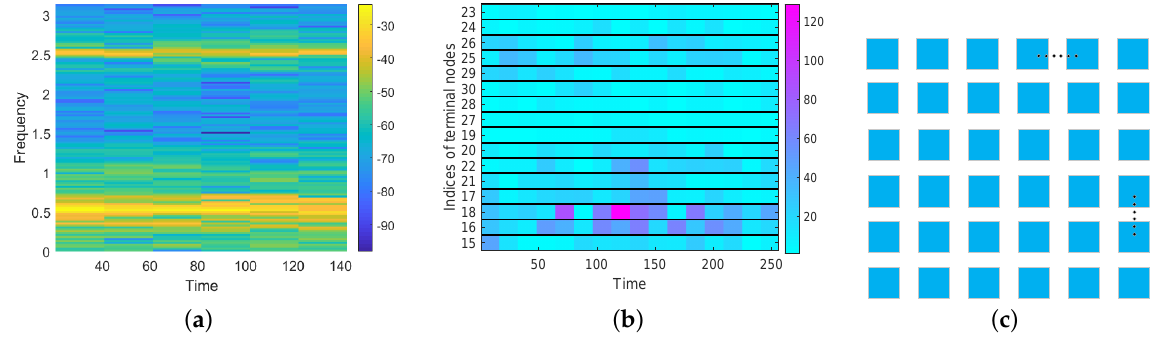
Figure 3. Signal preprocessing based on PE. ( a ) STFT. ( b ) WPD. ( c ) DMT. WPD: As illustrated by Figure 3b, WPD can decompose each vibration signal sample into a sub-band containing a series of wavelet coefficients through the wpdec function of MATLAB. WPD’s heat map horizontal axis represents time, the vertical axis represents different sub-bands, and different colors represent different values. WPD is a widely used time–frequency analysis method. The equation of WPD is expressed as: